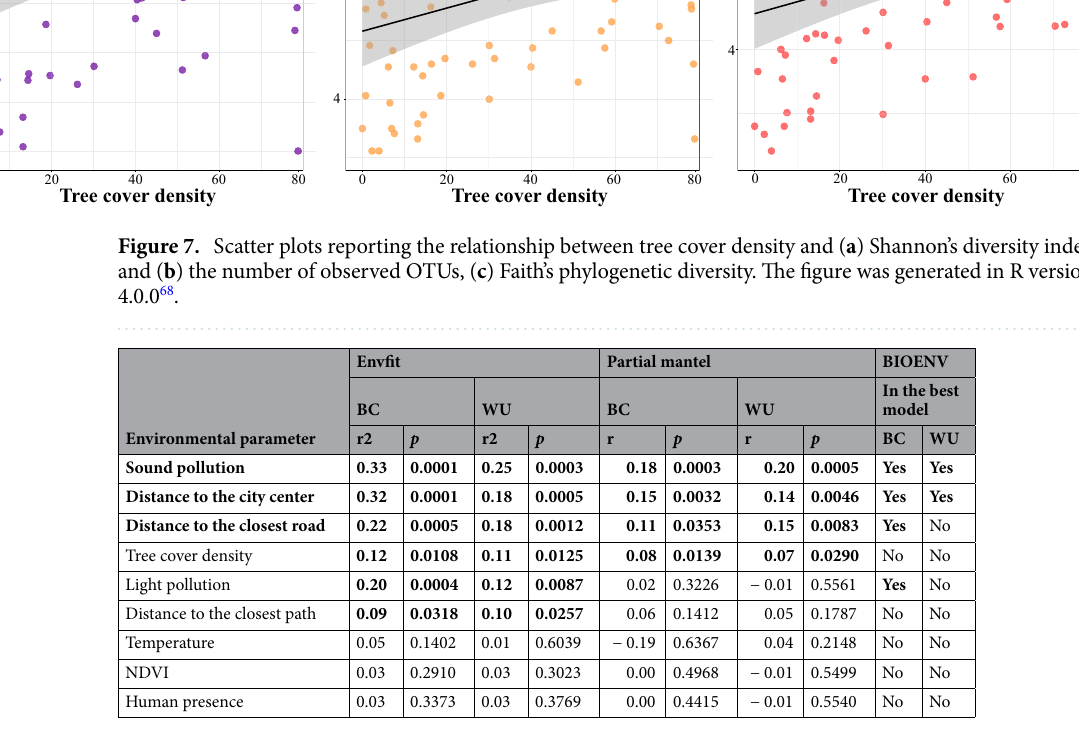
Table 1. Summary of the statistical tests used to investigate the interaction between environmental variables and beta diversity. The bold significance was determined based on Envfit or partial mantel test, at p-values ≤ 0.05 or being selected by the best BIOENV